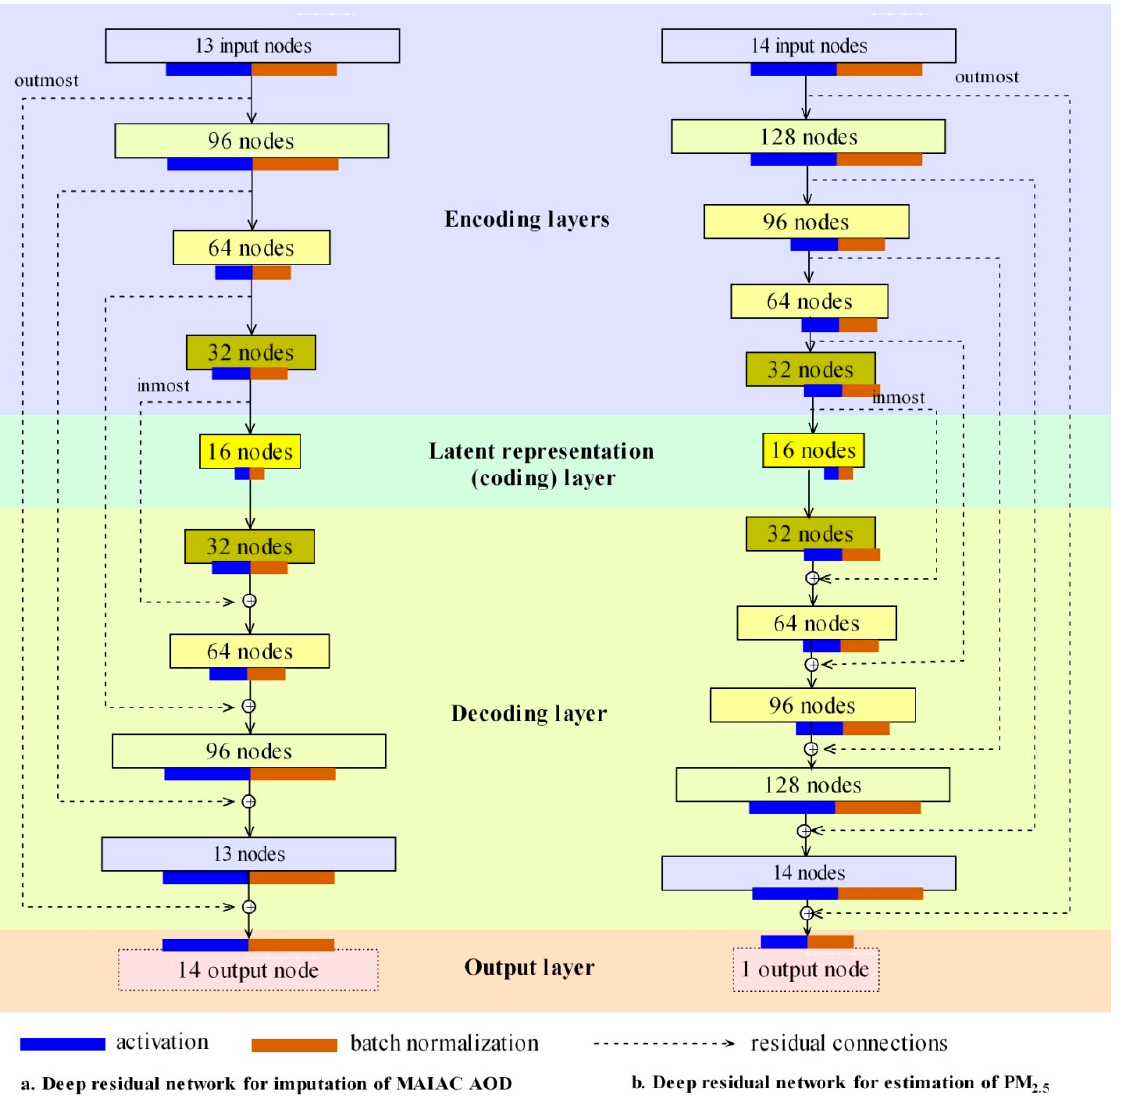
Figure 2. Autoencoder-based residual deep networks for imputation of MAIAC (multiangle implementation of atmospheric correction) AOD (aerosol optical depth) ( a ) and spatiotemporal estimation of PM 2.5 ( b ).